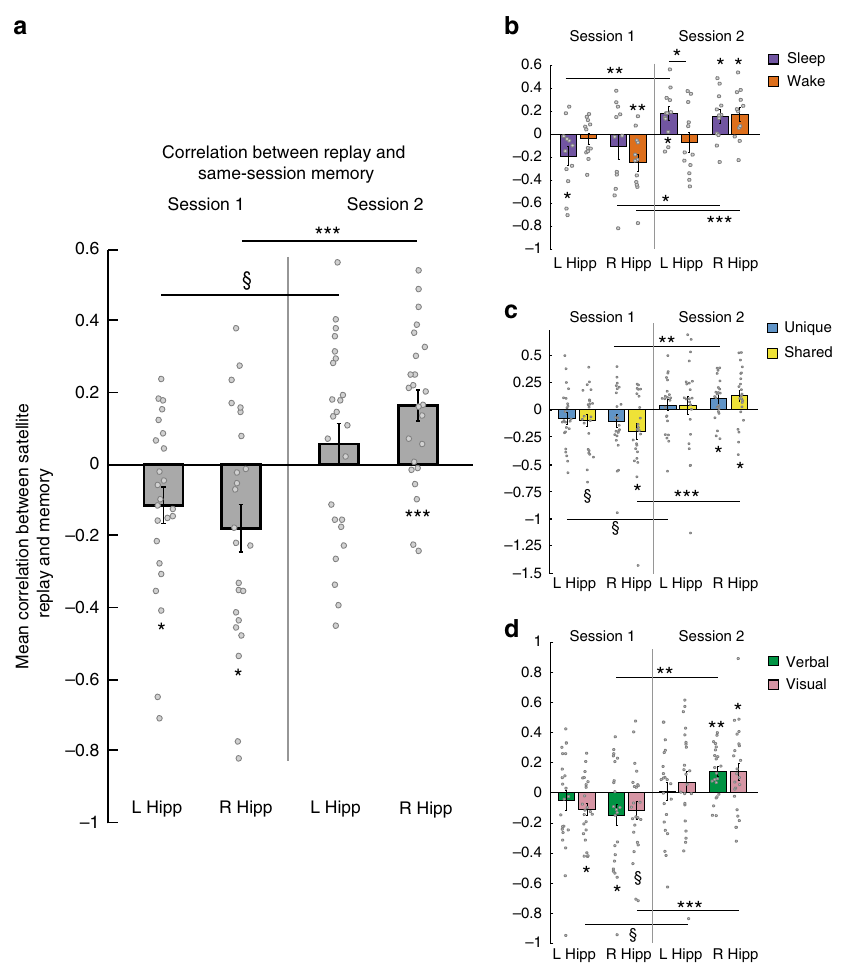
Fig. 4 Within-session replay – behavior relationships. a Correlation between memory in Session 1 and replay in Session 1, and between memory in Session 2 and replay in Session 2, in left (L Hipp) and right (R Hipp) hippocampus. b Same data, broken down by Sleep and Wake groups. c Same data, broken down by memory for unique and shared features. d Same data, broken down by memory for verbal and visual features. § p < 0.1, * p < 0.05, ** p < 0.01, *** p < 0.001, t -test. Error bars denote ± 1 SEM; n = 24 for all bars except b , where n = 12 for each